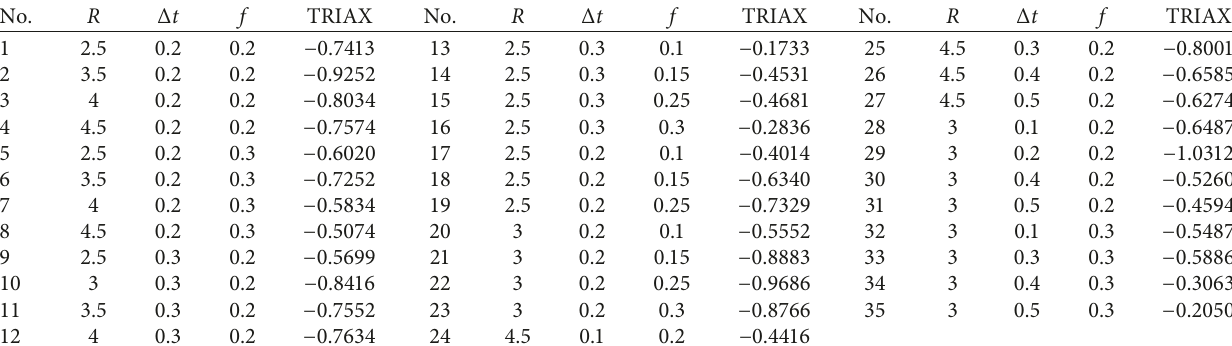
Table 2: Average stress triaxial value for different process parameters.